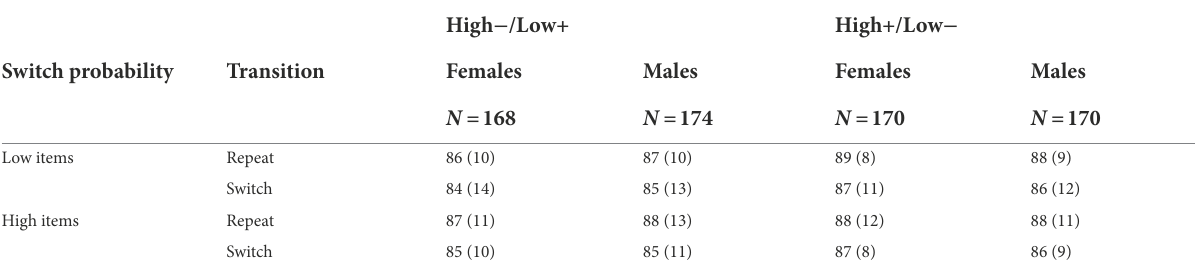
TABLE 8 Mean accuracy (%) with standard deviations in Experiment 2 as a function of background valence, switch probability, and transition separately in males and